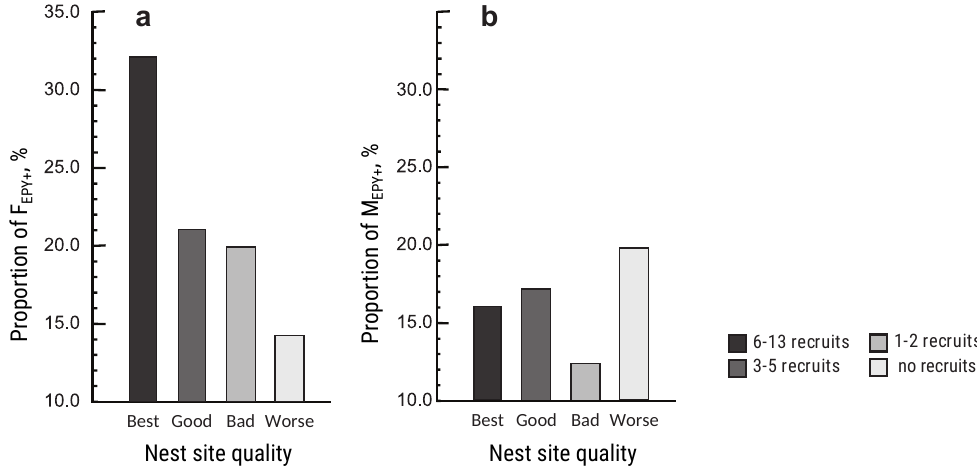
Figure 7. The proportion of females ( a ) and males ( b ) with EPY ( F EPY + and M EPY + , respectively) among individuals nesting in territories of different quality. Territory quality was determined by the number of recruits born in the